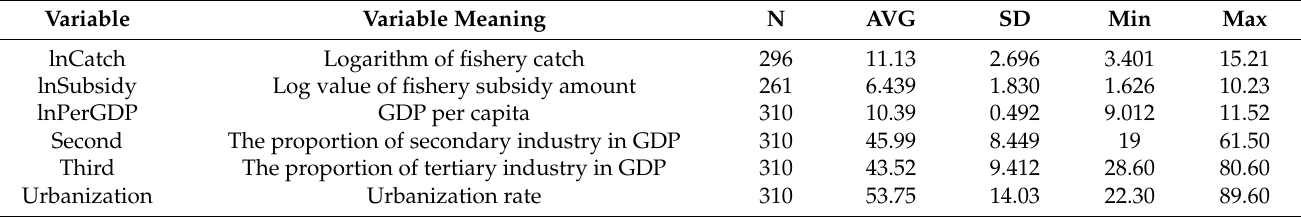
Table 1. Descriptive statistics of